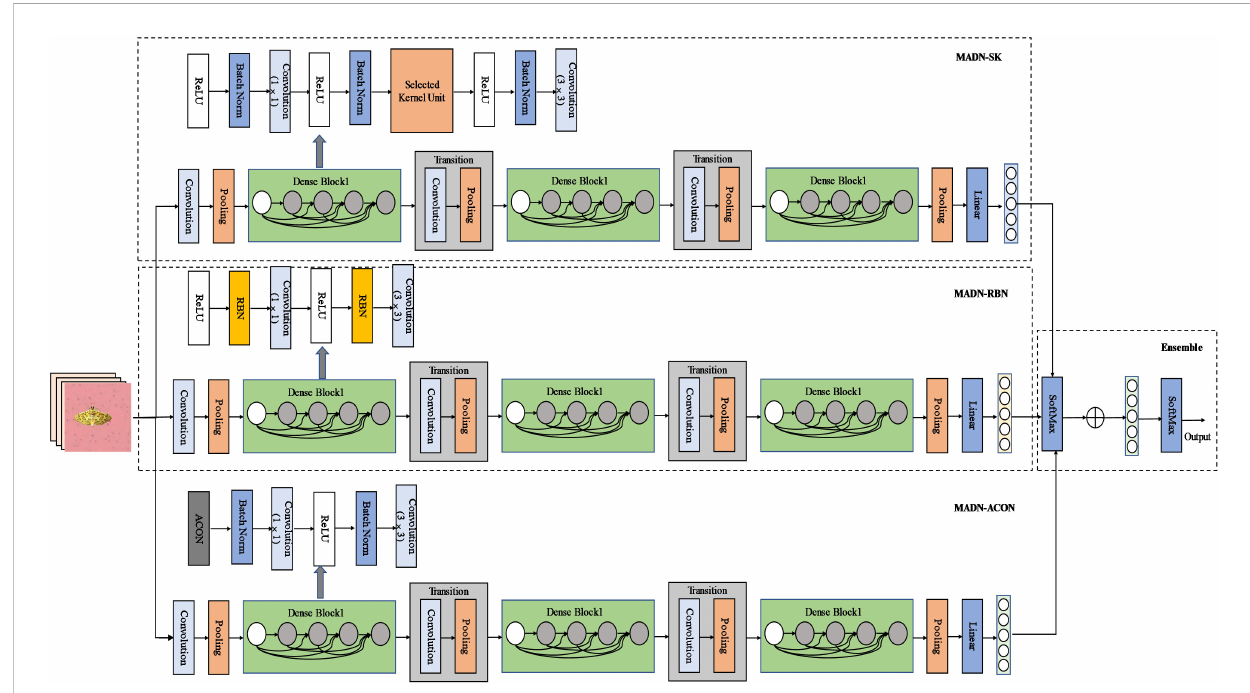
FIGURE 3 Structure of the MADN network model. The dense connection lines are omitted from the diagram, and the connections are made in the same way as the original